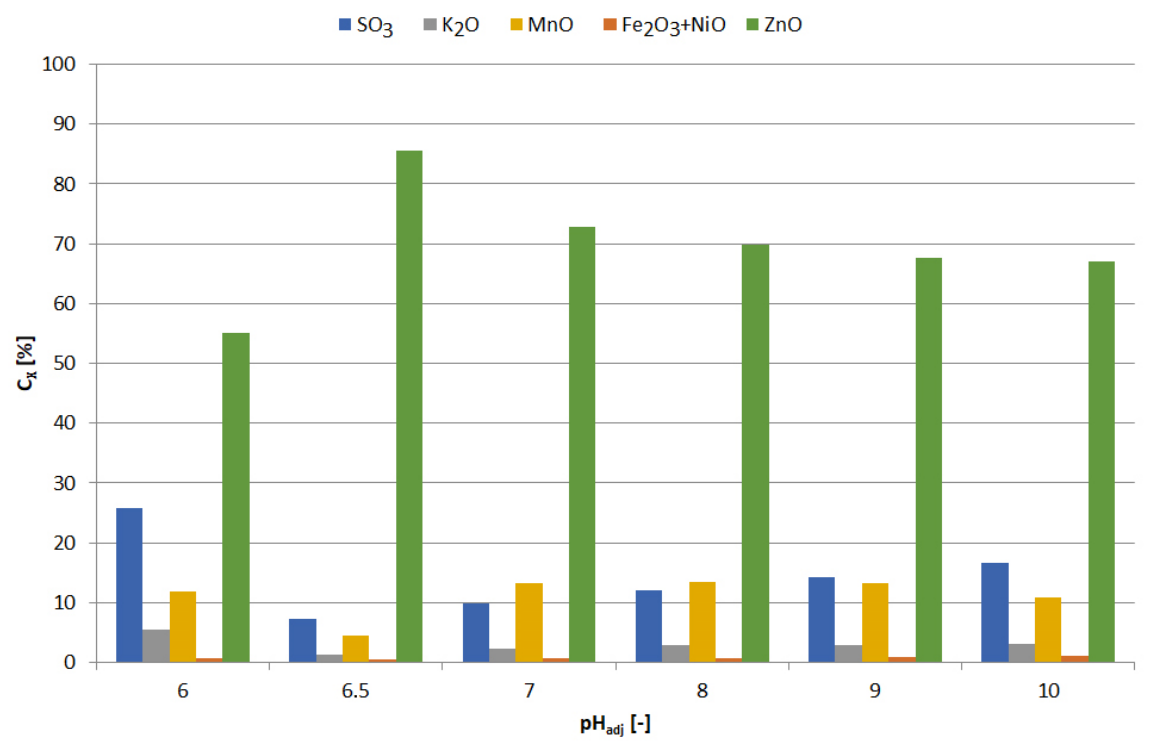
Figure 30. Effect of adjusted pH (pH adjusted ) on chemical composition of precipitates as a result of precipitation by using Na 2 CO 3 from selective leaching solution.